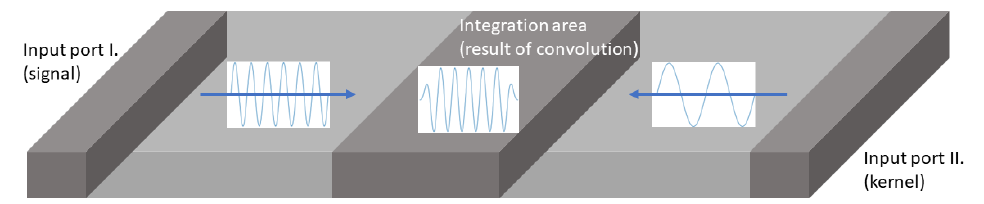
Figure 1. This figure depicts a primitive three-port elastic SAW convolver. Two signals travel in opposite directions from the two input ports of the device (at the left and right edges of the device), and the convolved version of the two signals can be extracted at the integration area (in the middle of the device). This example shows how a physical system can be used to implement a complex operation in an energy-efficient